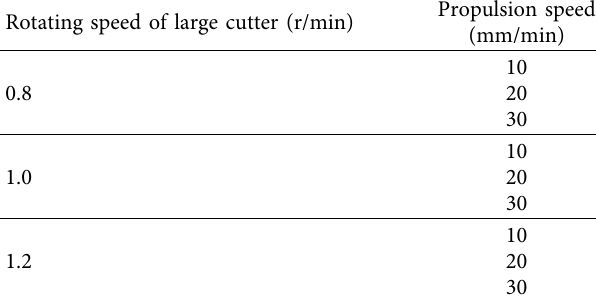
Table 4: Velocity settings of cutterhead.